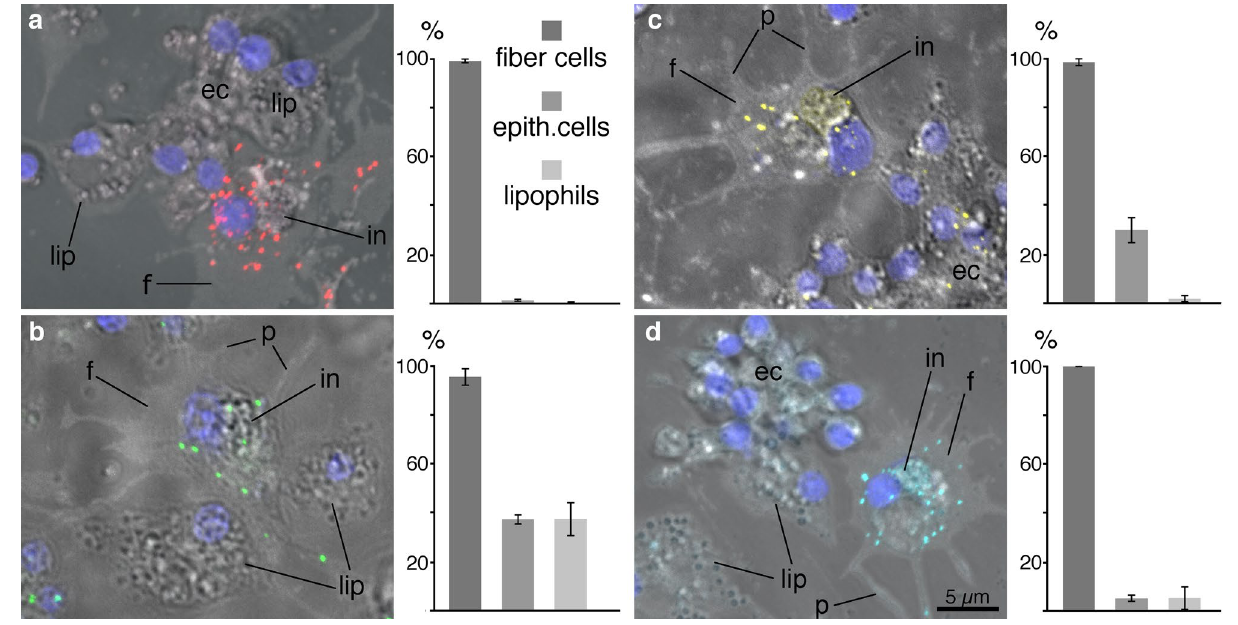
Figure 5. In situ hybridization with probes for the transcription factor foxC and for genes implicated in phagocytosis in dissociated cell samples. Images are maximum projections of fluorescence images captured with a confocal microscope superimposed on a transmitted light image. Fiber cells (f) were identified by their possession of a large inclusion (in) and processes (p); lipophil (lip) cells, by their content of numerous refractile vesicles; and spherical/columnar epithelial cells (ec, epithelial cells excluding lipophils and mucocytes), by their small sizes and smaller granules. The graphs show the percent of each cell type that was labeled (mean ± SEM). ( a ) A fiber cell labeled with Ta- foxC probe (red) adjacent to unlabeled lipophil and spherical/columnar epithelial cells. foxC is highly expressed exclusively in fiber cells. ( b ) A fiber cell labeled with Ta- cd36 probe (green) flanked by two unlabeled lipophil cells. cd36 is expressed in almost all fiber cells and in less than half spherical/ columnar epithelial cells and lipophil cells. ( c ) A fiber cell labeled with Ta- elmo probe (yellow) adjacent to a cluster of labeled and unlabeled spherical/columnar epithelial cells. elmo is expressed in almost all fiber cells and in a third of spherical/columnar epithelial cells, but not in lipophil cells. ( d ) A fiber cell labeled with Ta- pxmp2 probe adjacent to an unlabeled lipophil cell and cluster of spherical/columnar epithelial cells. Expression of pxmp2 is largely confined to fiber expressed by approximately one third of the lipophil cells and one third of the spherical/columnar epithelial cells. Approximately one third of the spherical/columnar epithelial cells expressed elmo , but very few lipophil cells expressed elmo . Fewer than ten percent of spherical/columnar epithelial cells and lipophil cells expressed pxmp2 . Fiber cells are involved in wound healing. To investigate wound healing, Trichoplax were cut in half (Fig. 6a). Time lapse video microscopy of wounded animals showed that the intact epithelia at the two margins of the wound extended toward each other, reducing the area of the wound, and after about one hour fused, thereby closing the wound (Fig. 6a, Supplementary Movie S5). During early stages of this process, the two mar- gins of the wound sometimes moved away from each other, reopening the wound, but as time passed reopenings occurred less frequently. To determine whether fiber cells participate in wound healing, we stained wholemounts of intact and wounded animals with anti-FC antibodies to label fiber cells, WGA to label mucocytes (Type 2 gland cells), which are prevalent in the marginal zone but also present further in the interior, and Hoechst dye to label nuclei. In intact animals, the outermost 10 µm of the marginal zone was composed of tightly packed VEC and overlaying DEC (Fig. 6b). A row of mucocytes (red cells in Fig. 6b) was located 10 to 30 µm from the rim. Fiber cells were present beginning ~ 10 µm from the edge and extending throughout the marginal zone (Fig. 6b) and lipophil zone (not illustrated). In wounded animals, the cut edge changed strikingly from the intact one. Fiber cell accumulated near the wound edge by five minutes after surgery (Supplementary Fig. S4a). Fiber cells were in contact with the seawater and their cell bodies were stretched along the wound parallel to the cut edge. Thirty minutes after wounding, fiber cell bodies were more elongated and their processes were aligned along the cut edge (Fig. 6c, inset). At both 5 and 30 min, fiber cells exposed directly to the seawater had much brighter anti-FC labelling than fibers cells in the interior. High level of foxC expression was apparent along the cut edge, consistent with presence of fiber cells in this area (Supplementary Fig. S4b). To determine the time course of physical sealing of a wound, we bathed Trichoplax in fluorescent 70 kDa dextran, which normally does not penetrate inside the intact animals (Fig. 7a 18 ). In animals that were cut in half after the dextran was added mesh-like staining was visible inside the body (Fig. 7b). This pattern suggests that extracellular space was stained 18 , as expected if dextran penetrated the wound. In animals that were cut 30 or